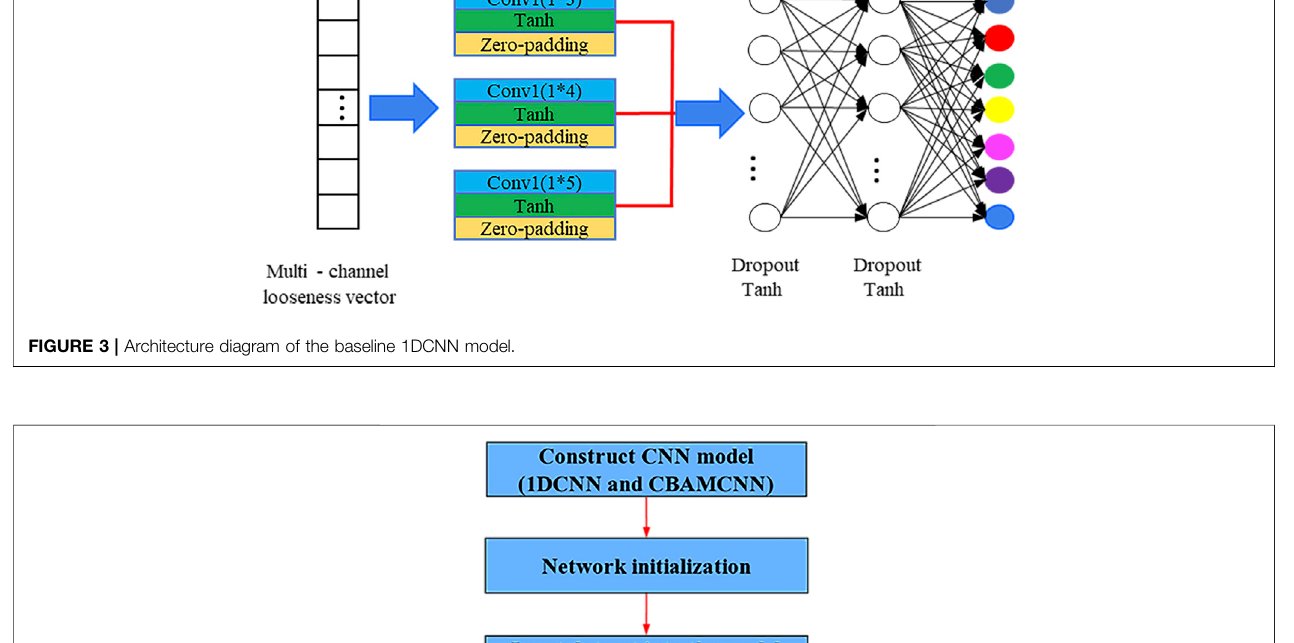
Frontiers in Materials |